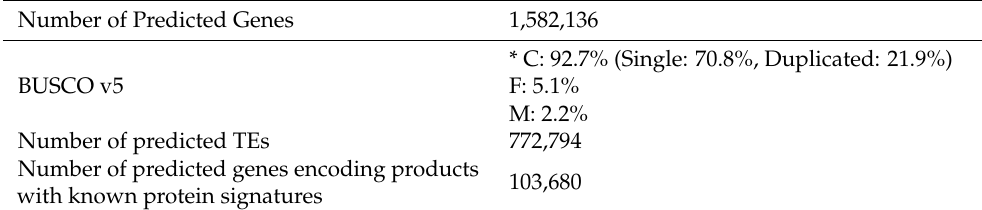
Table 3. Annotation statistics for the draft